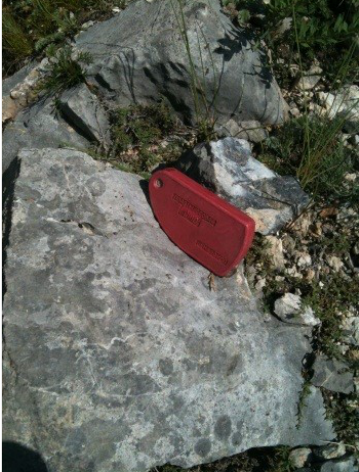
Fig. 7. SEM images of phosphatic small shelly fossils. A–D) Chancelloriid sclerites; E) hyoliths; F) Possible hyolith; identification uncertain (After Pruss et al., 2017). Lower Cambrian, Salaanygol